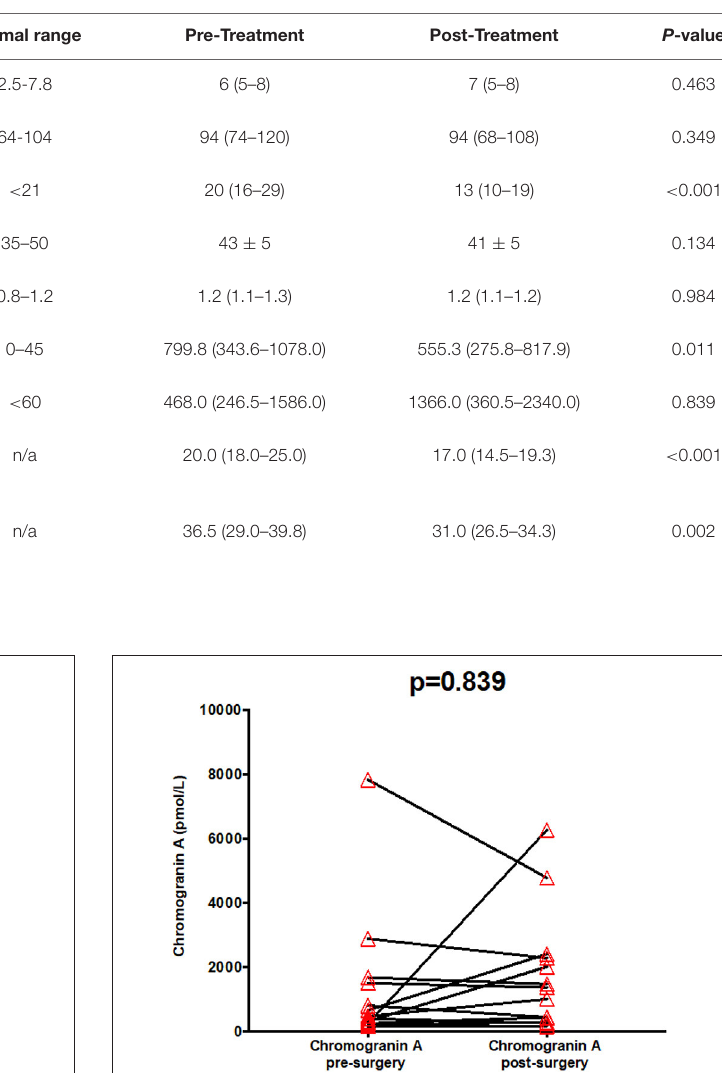
TABLE 2 | Summary of markers, before and after surgery.